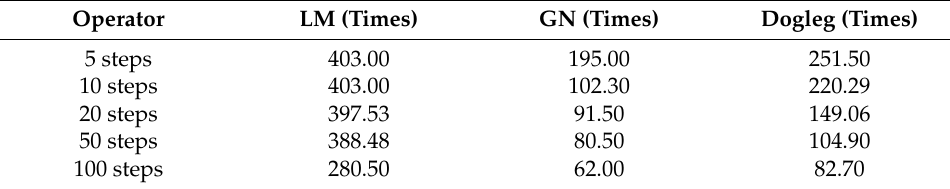
Table 2. The efficiency of three tracking operators in homotopy algorithms.